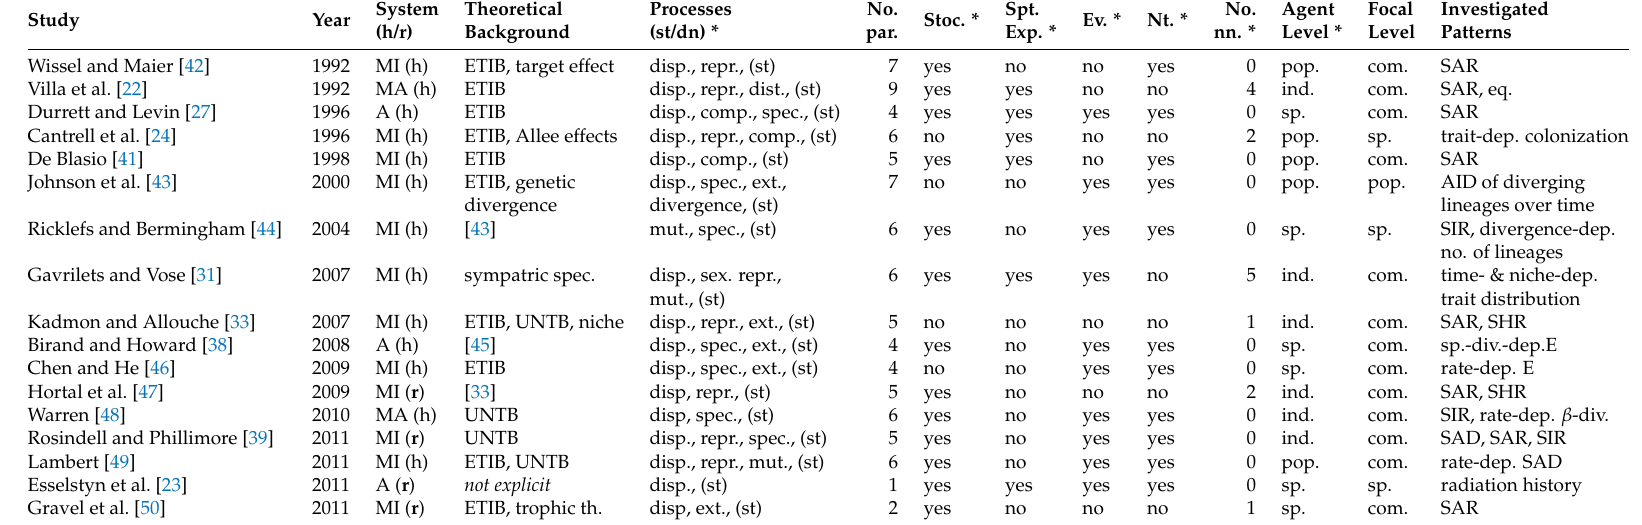
Table 1. Studies with process-based models for island biogeography. Papers are sorted chronologically. The system column also contains information on whether the model simulates a purely hypothetical (h) or real-world system (calibrated with data, r ). Columns that were used for Figures 2 and 3 are marked with an asterisk (*). A: archipelago; AID: area-isolation-dependency; com.: community; comp.: competition; dep.: dependent; disp.: dispersal (includes immigration for species-based models and establishment for population-based models; dist.: disturbance; div.: diversity; E: endemics; eq.: equilibrium; ETIB: equilibrium theory of island biogeography; Ev.: evolutionary processes; ext.: extinction; GDM: general dynamic model of oceanic island biogeography; I: island; ind.: individual; MA: mainland-archipelago; MI: mainland-island; mut.: mutation; No. nn.: number of non-neutral niche axes, specific to species or individuals; No. par.: minimum number of easily identifiable parameters (e.g., constants, rates); Nt.: neutral; phyl.: phylogenetic; pop.: population; repr.: reproduction; SAD: species-abundance-distribution; SAR: species-area-relationship; SHR: species-heterogeneity-relationship; SIR: species-isolation-relationship; spec.: speciation; sp.: species; Spt. exp.: spatially explicit; st/dn: static or dynamic environment; Stoc.: stochastic; th.: